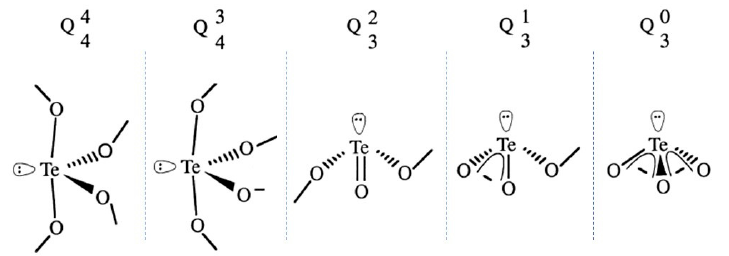
Figure 2. Schematic of the Q mn units in the tellurite glasses, modified from [42].